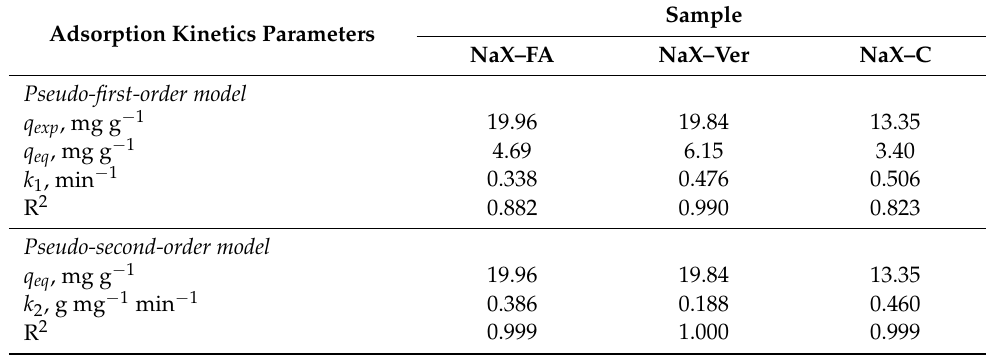
Table 4. Adsorption kinetics parameters of NH 4+ ion adsorption onto zeolites NaX–FA, NaX–Ver, and